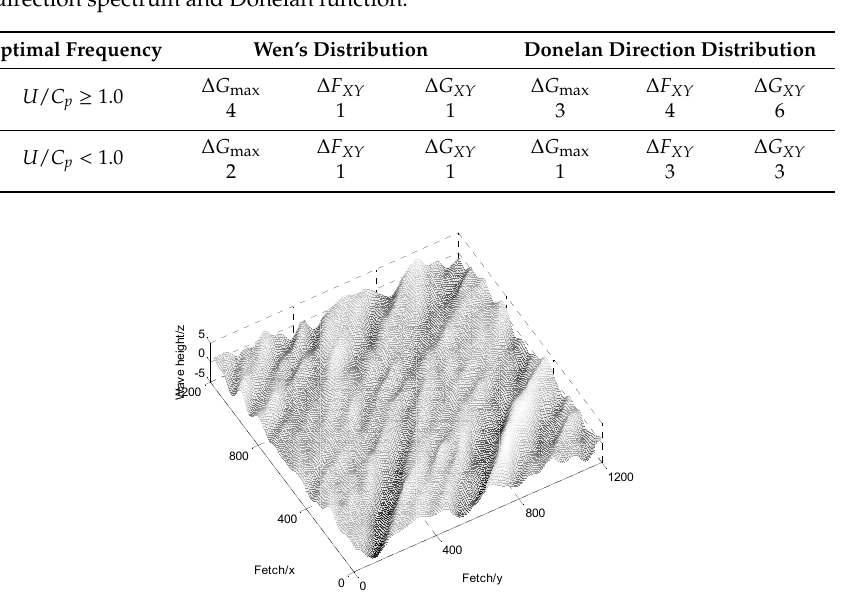
Table 2. The optimal frequency based on the statistical minimum error value in the fitting experiment of Wen’s direction spectrum and Donelan function.